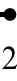
G ( z 1 ; z 2 ) = (cid:0) @ z 2